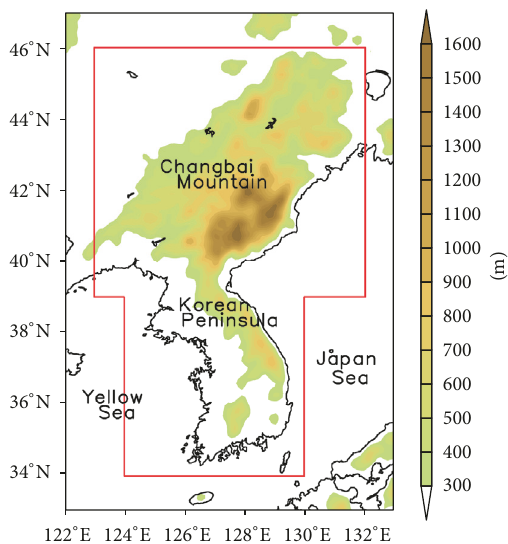
Figure 1: Topography in the vicinity of the Korean Peninsula. Shadingdenotesthesurfaceheight(m)fromsealevel.Theillustrated red rectangle designates the domain where mountain elevation is modified as a height of 0